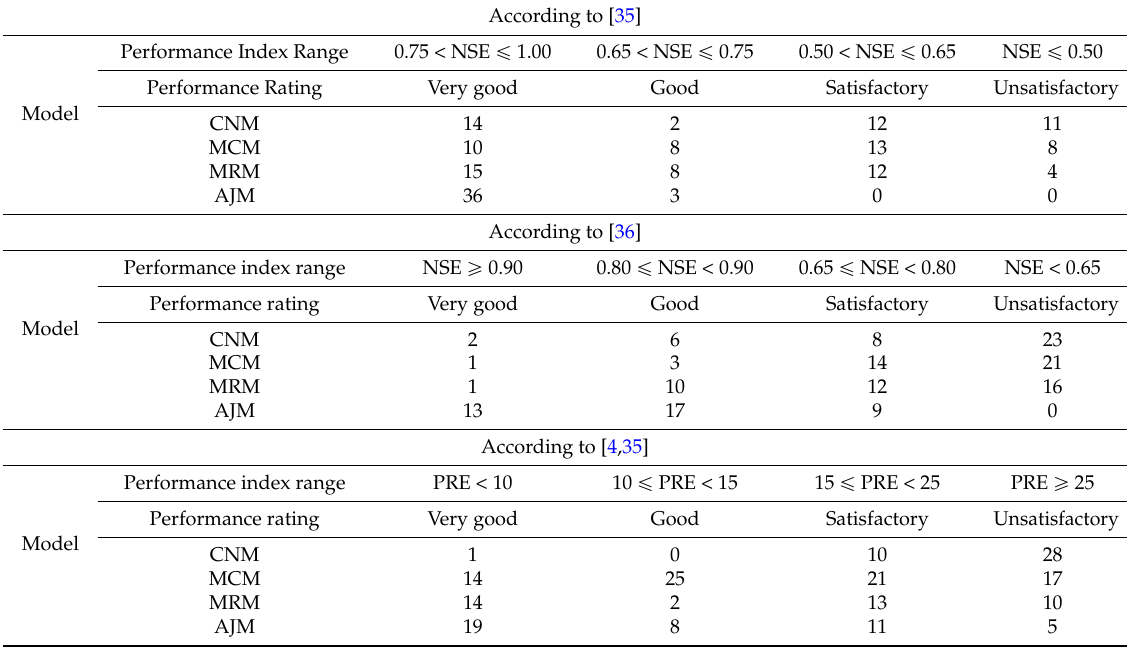
Table 4. Model performance ratings in 39 watersheds based on different statistical indicators.